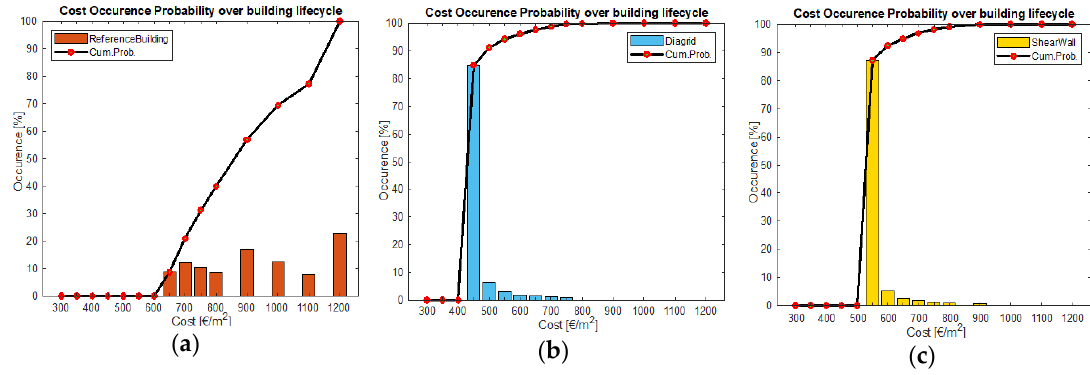
Figure 8. Cost occurrence probability for ( a ) non-retrofitted reference building, retrofitted building with ( b ) diagrid and ( c ) shear walls.